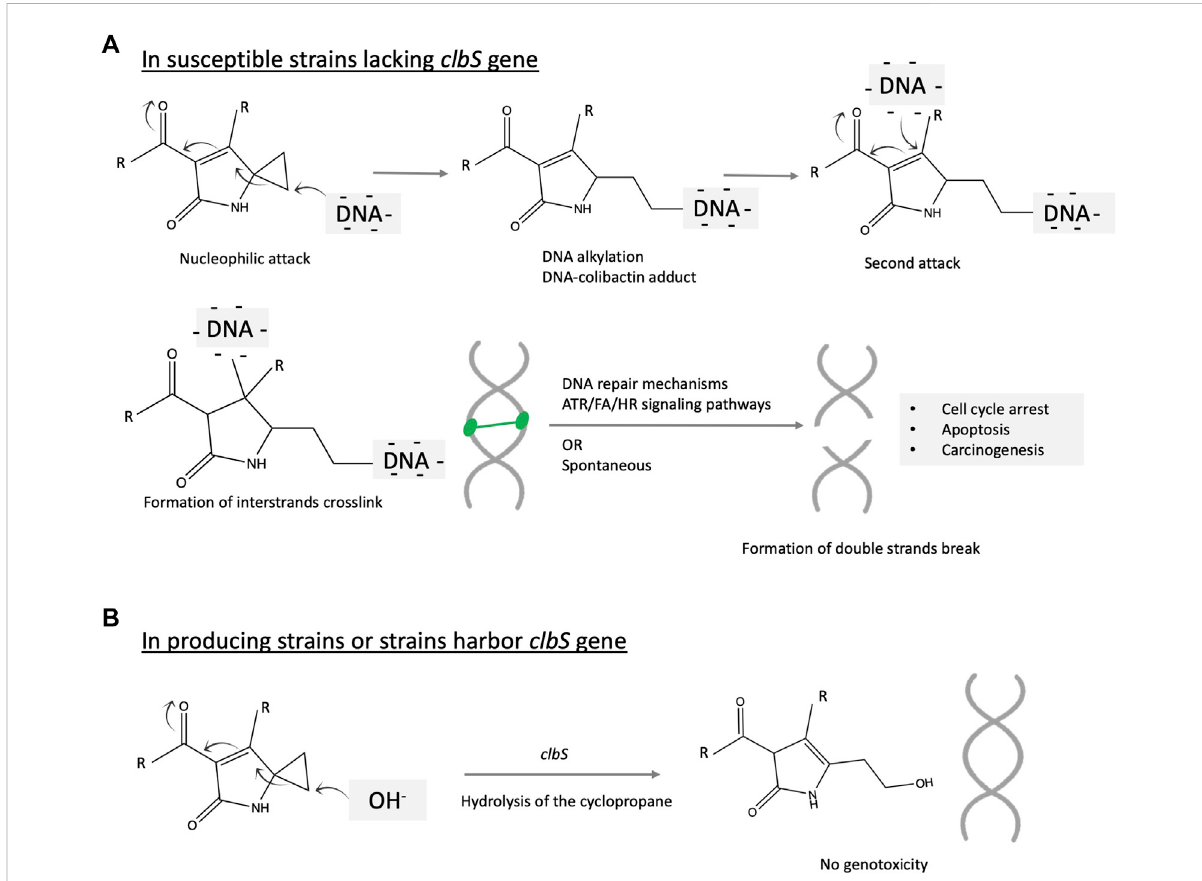
FIGURE 4 Illustrationoftheproposedmechanismofcolibactinmutagenesisontheeukaryoticcell.Thekeystructuralscaffoldsmediatingthismechanism is the azospirobicyclic ring (warhead). The process is initiated by a nucleophilic attack on the electrophilic ring, which results in DNA alkylation and creates another electrophilic center subjected to a second alkylation reaction. Two alkylation events cross-link the DNA, which further activate multiple and complex DNA repair mechanisms including Ataxia telangiectasia mutated-and Rad3-related (ATR), Fanconi anemia (FA), homologous recombination (HR) signaling pathways. The DNA double strands break may be the product of the repair system or spontaneously formed. Accumulation of this mutation might initiate colorectal